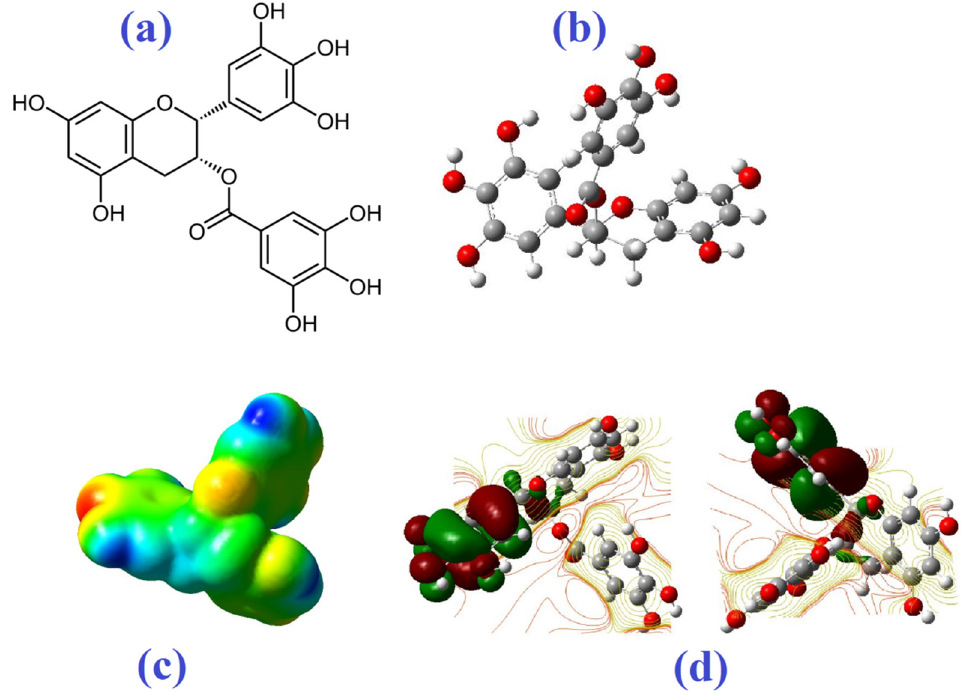
Figure 8. The molecular structure ( a , b ), total electron density maps ( c ), 3D model of HOMO-LUMO molecular orbitals, and ( d ) contour plots (side view: left ; front view: right ) of EGCG. Quercetin as a flavonoid compound has three aromatic rings with a 15-carbon skeleton bonded by oxygen atoms encapsulated in a heterocyclic ring (Figure 9a,b) [60–62]. In Figures 8c,d and 9c,d, a higher density of electrons is shown in red color and a lower density of electrons is shown in blue color. The aromatic ketone of EGCG and quercetin with more electrons can be attacked by electrophilic residues in ligand-binding cavities.